Question: Looking at the figure, what chart type is it?
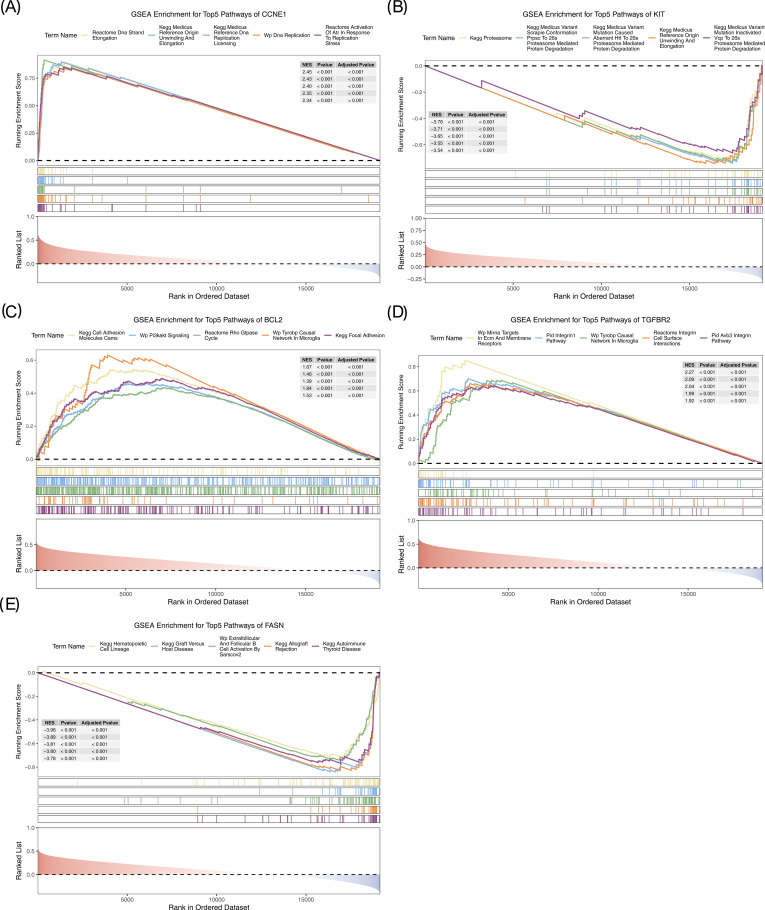
Answer: line